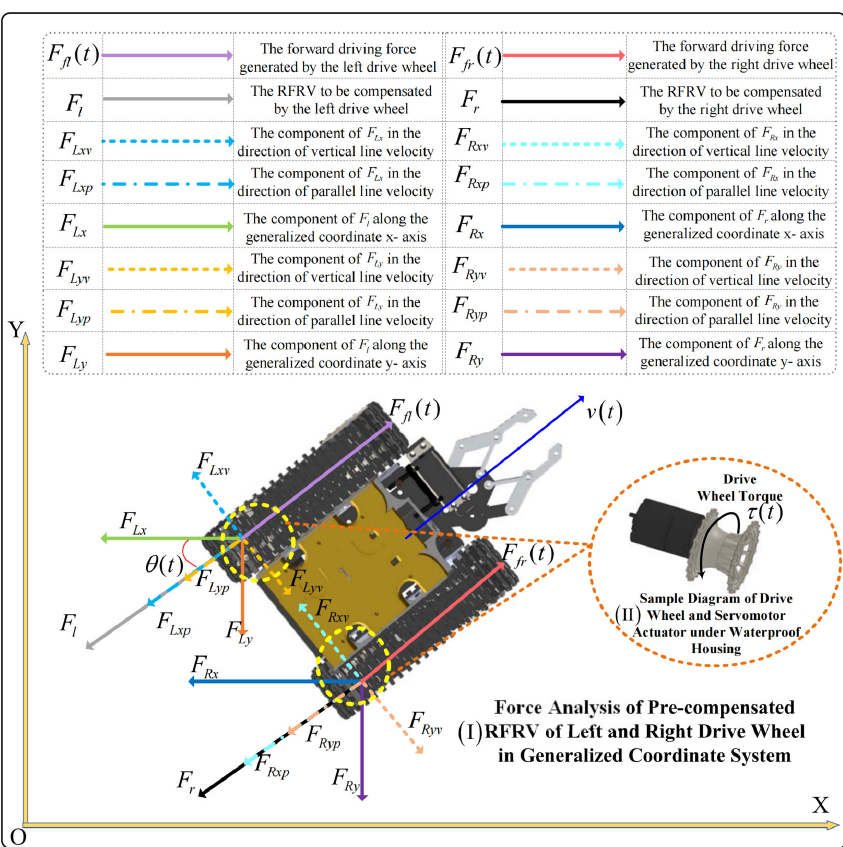
Figure 3. (I) Schematic of Force Analysis of Pre-compensated RFRV of Left and Right Drive Wheel in Generalized Coordinate System. (II) Schematic diagram of servomotor actuator